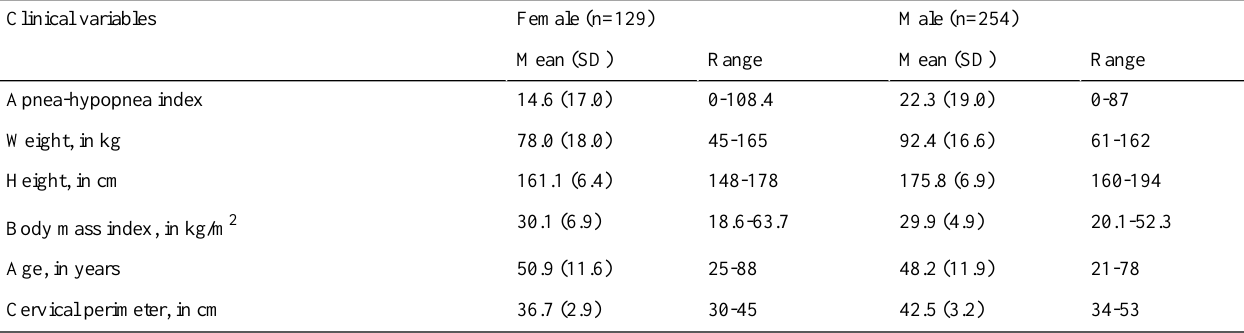
Table 1. Descriptive statistics on Spanish female and male subjects.